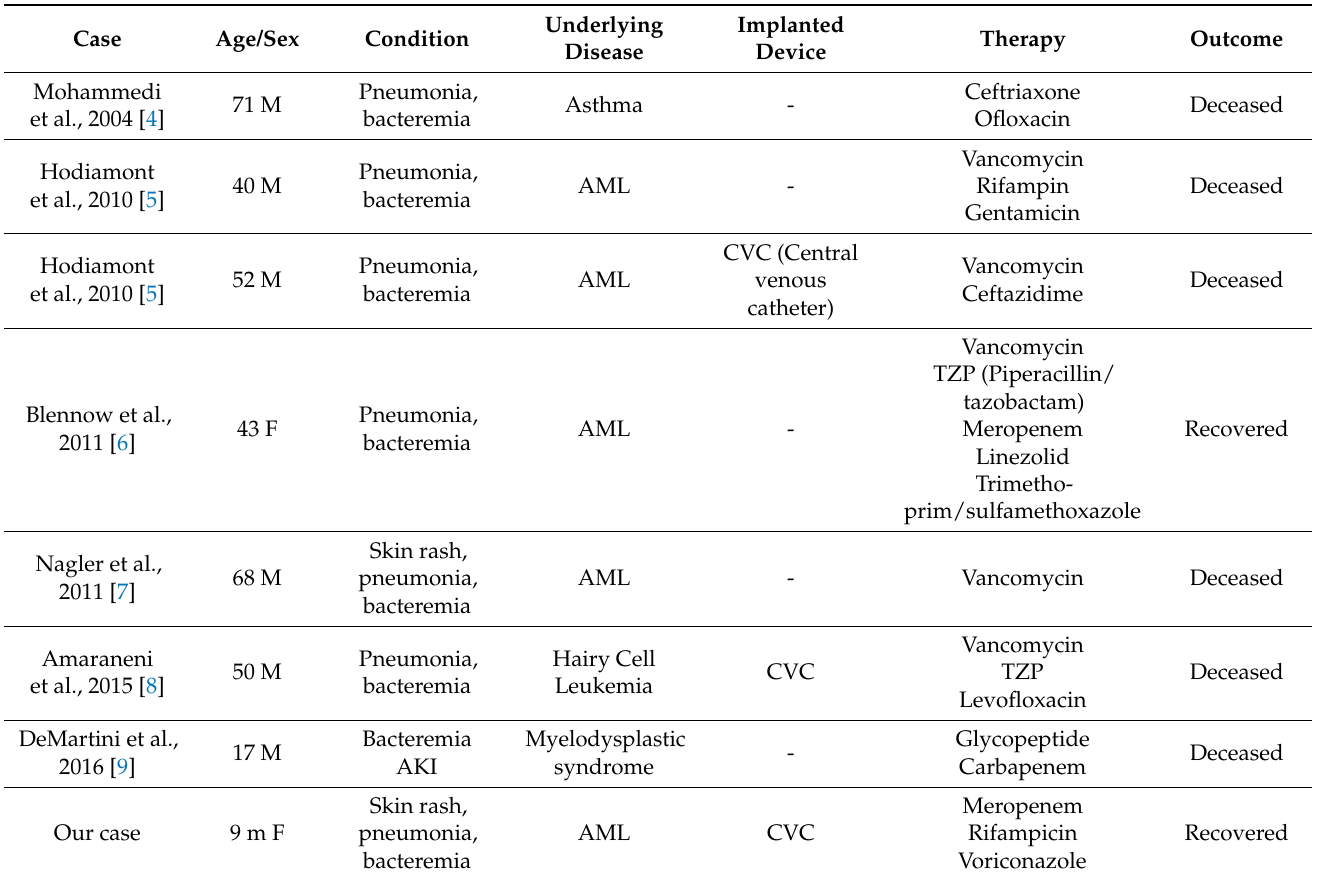
Table 2. Immunosuppressed